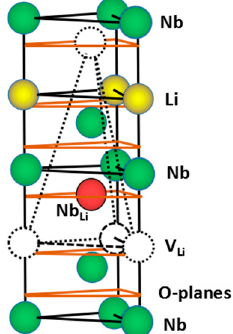
Figure 1. Schematic of the defect structure of a congruent LiNbO 3 crystal [20,38].